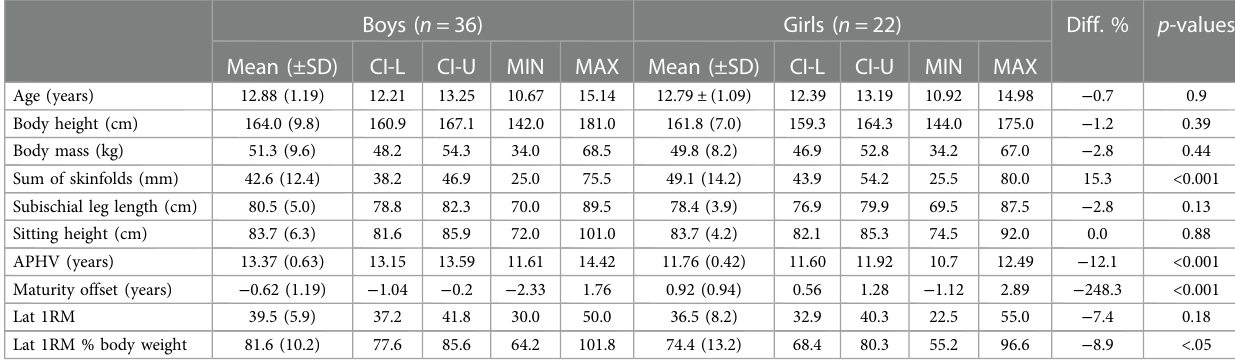
TABLE 1 Age and anthropometrics, lat test